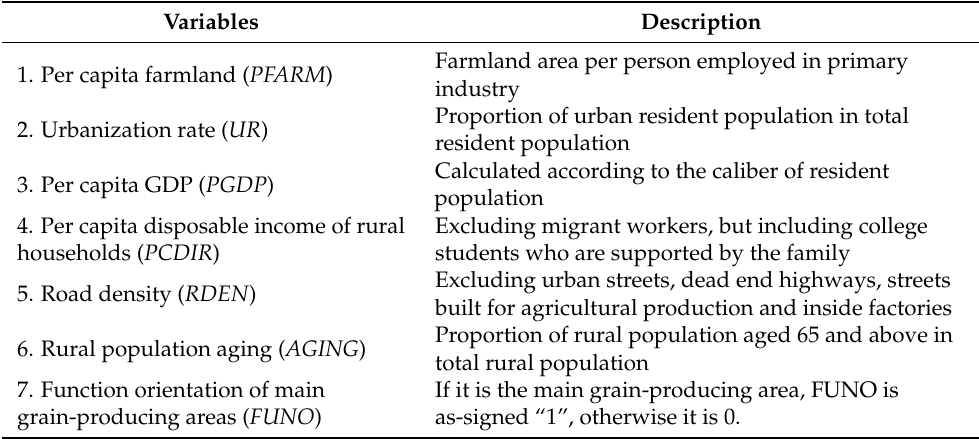
Table 1. The selection of influencing factors behind